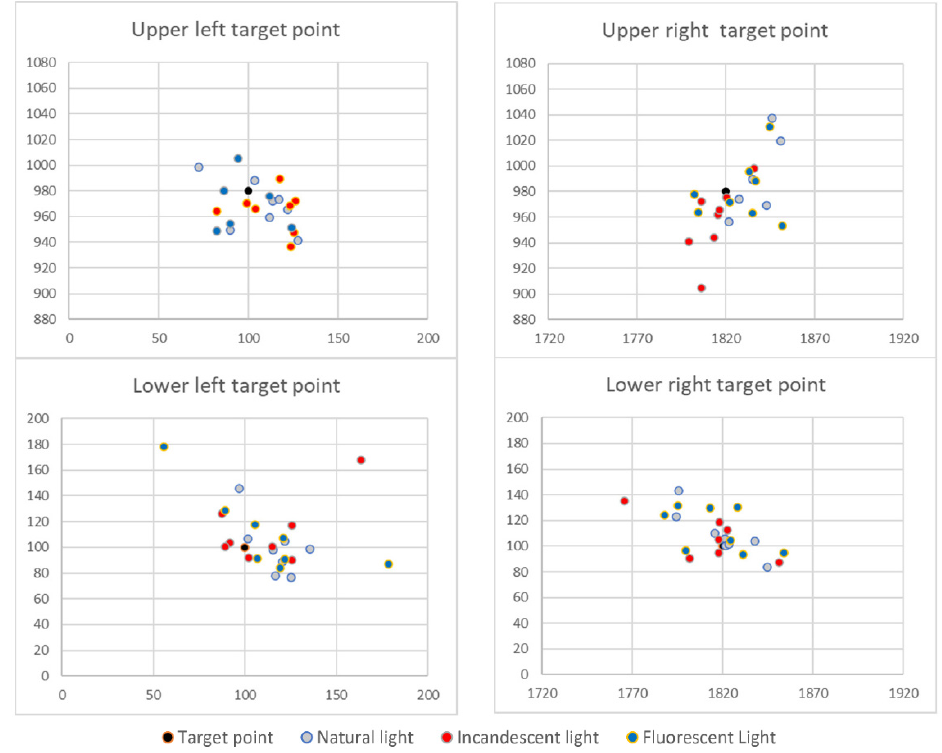
Figure 2. Centroids dispersion for corner target points in different lighting conditions.